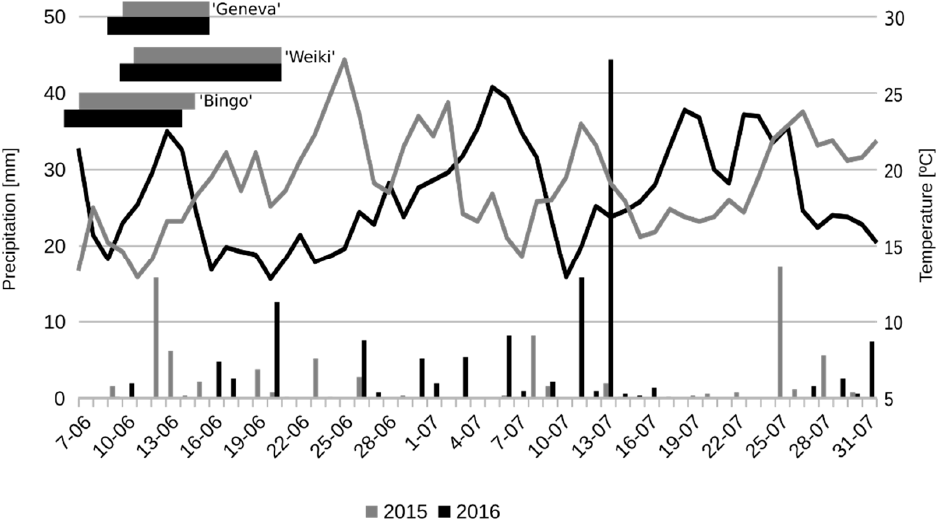
Figure 1. Temperature and precipitation during the flowering period and intense fruit growth in comparison to the flowering period of tested female A. arguta